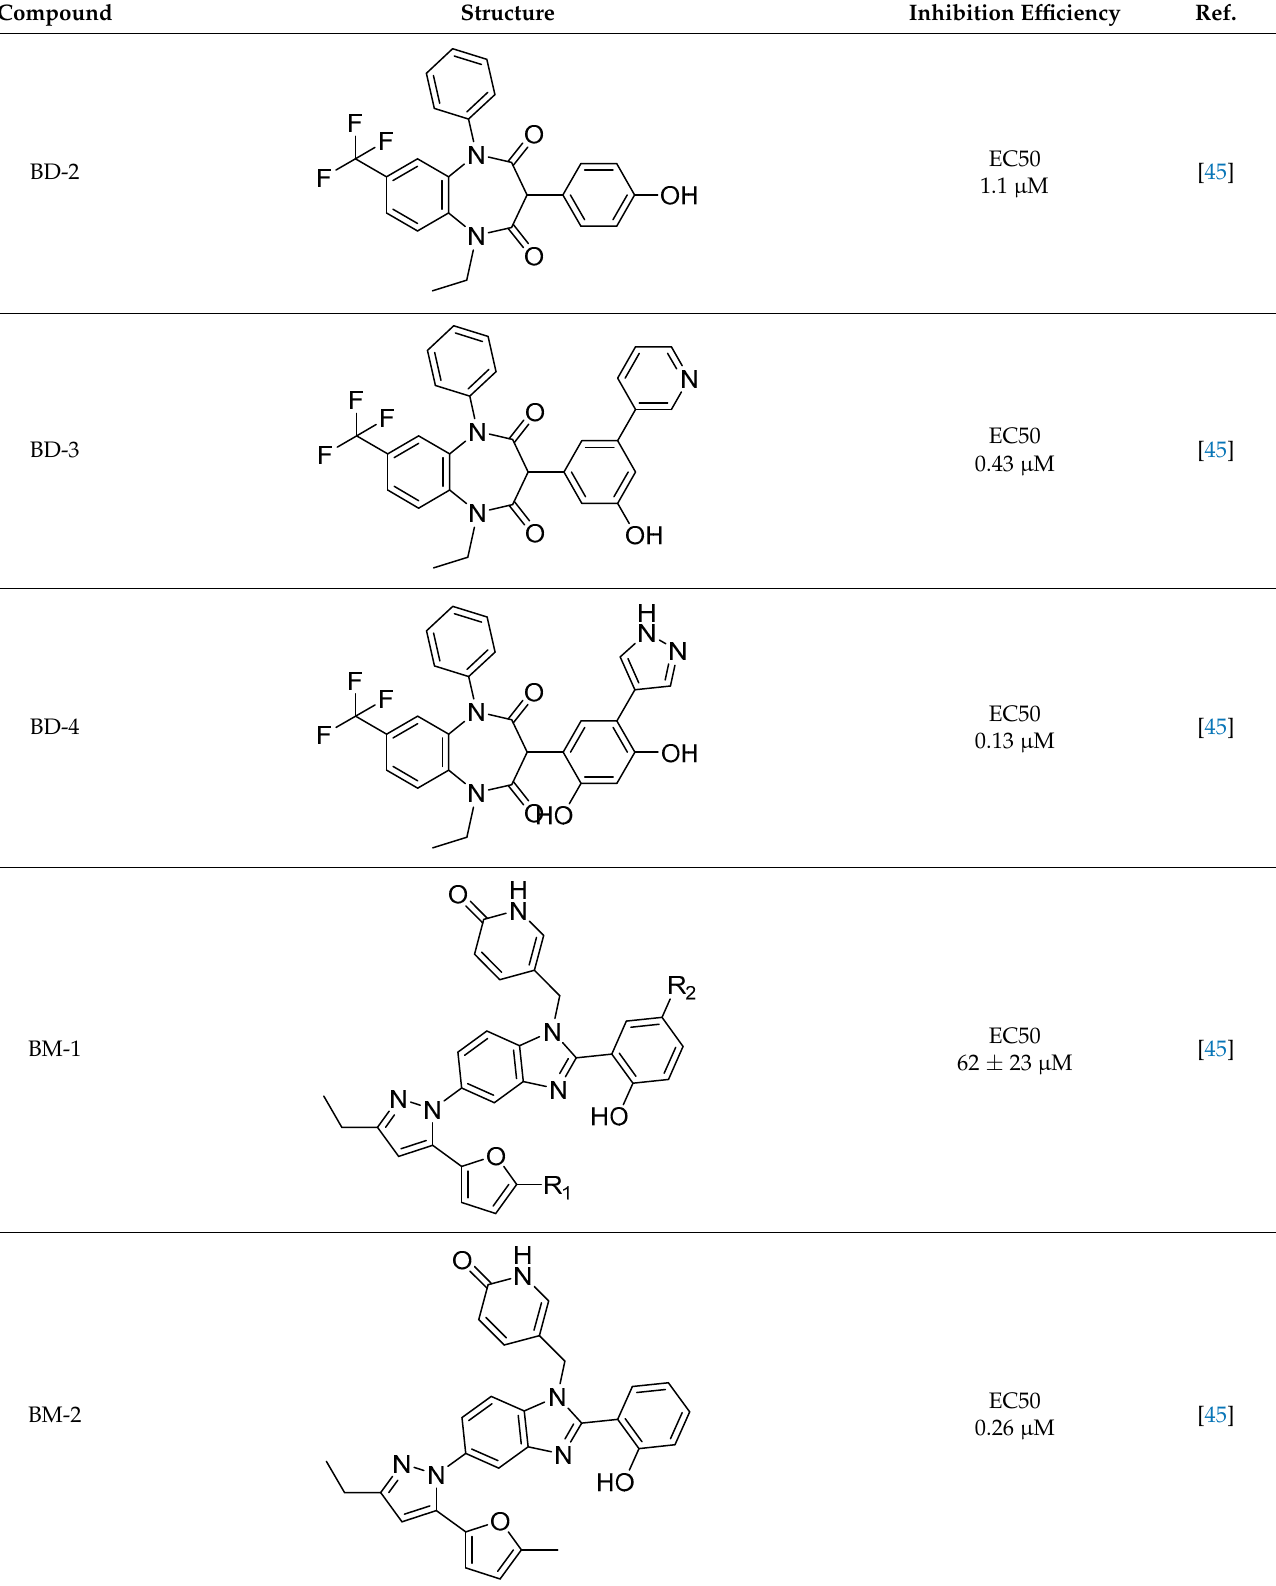
Table 1. Cont. Compound Structure Inhibition Efficiency